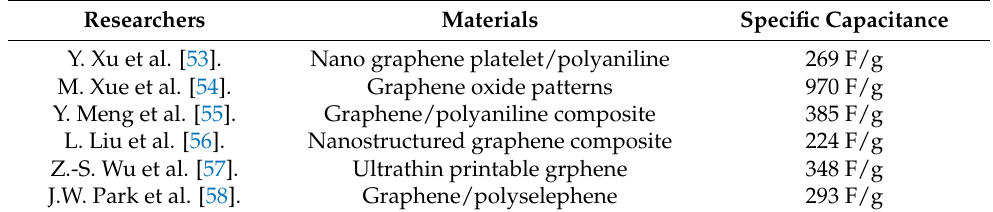
Table 3. Electrochemical performance of some of the previously reported ternary composites.